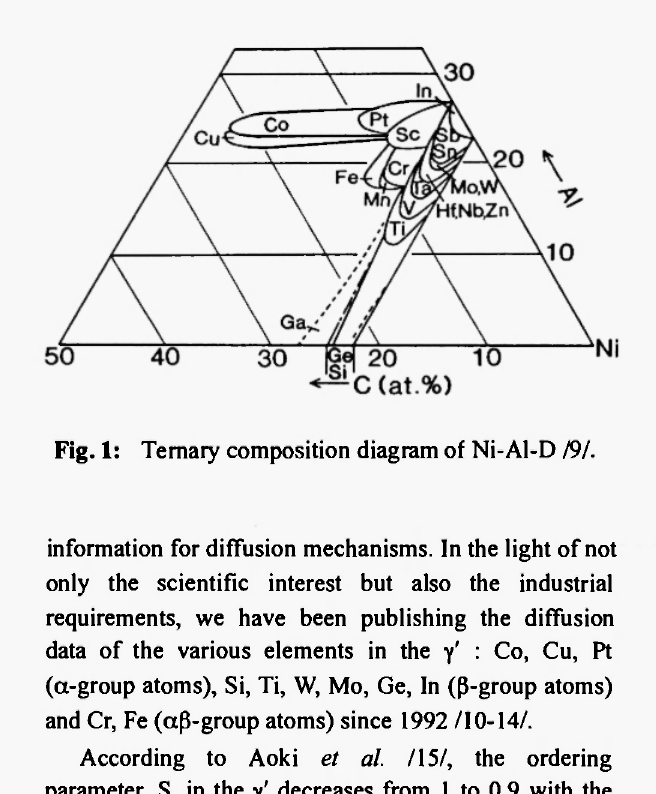
information for diffusion mechanisms. In the light of not only the scientific interest but also the industrial requirements, we have been publishing the diffusion data of the various elements in the γ' : Co, Cu, Pt (α-group atoms), Si, Ti, W, Mo, Ge, In (ß-group atoms) and Cr, Fe (αβ-group atoms) since 1992 /I0-14/.